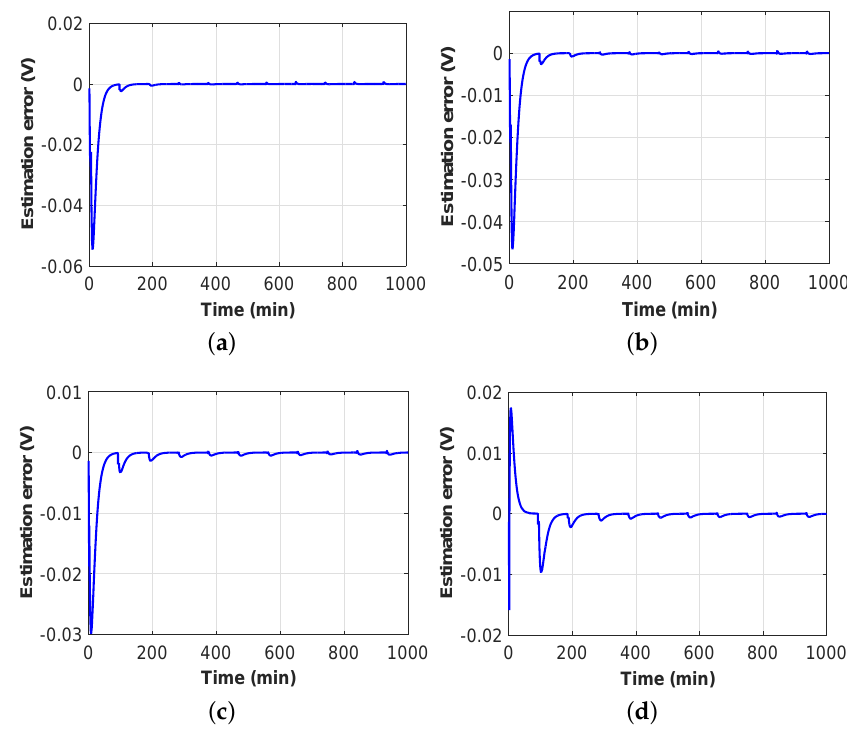
Figure 6. Relative error at different temperatures in charge mode. ( a ) 0 ◦ C; ( b ) 10 ◦ C; ( c ) 25 ◦ C; and ( d ) 40 ◦